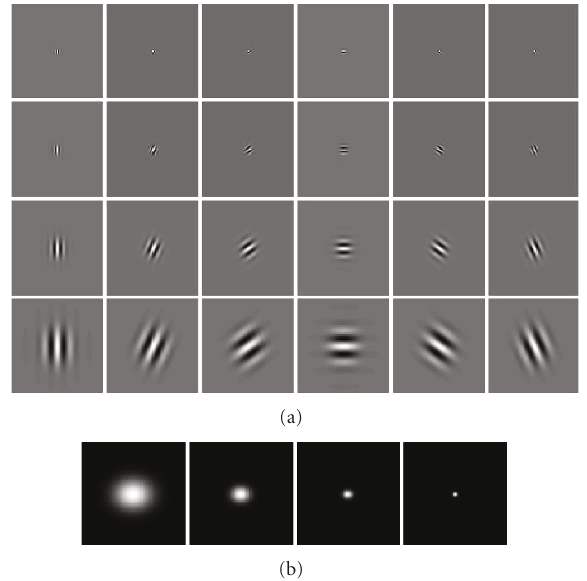
Figure 1: Gabor wavelets. (a) The real part of the Gabor kernels at four scales and six orientations. (b) The magnitude of the Gabor kernels at four di ff erent scales.